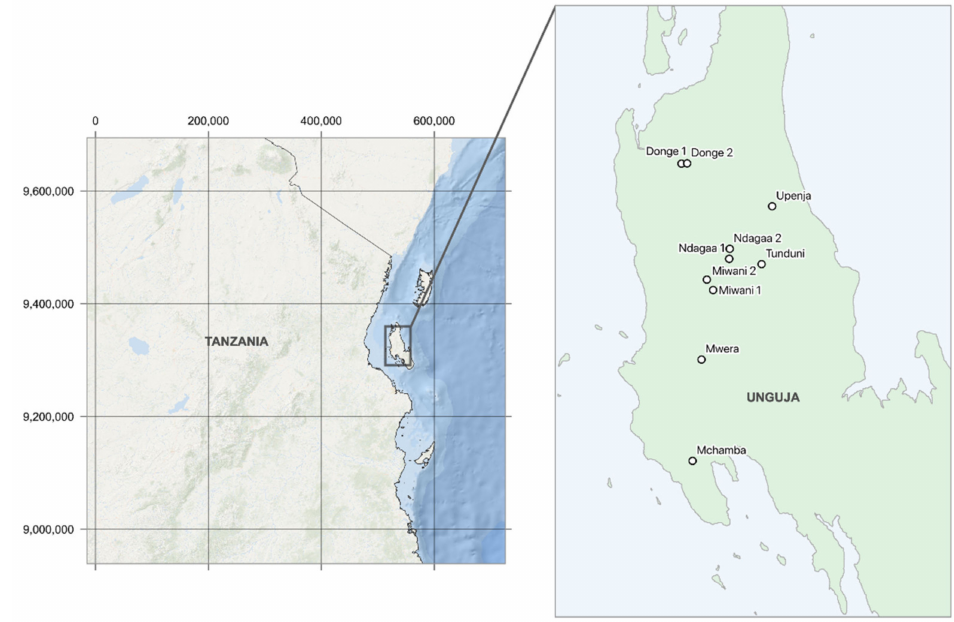
Figure 1. Study site locations on the island of Unguja, in the Zanzibar Archipelago, United Republic of Tanzania. Basemap data from ESRI World Ocean